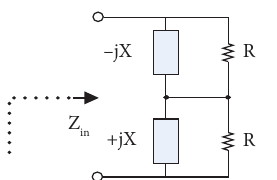
Figure 2: A specifc parallel circuit.